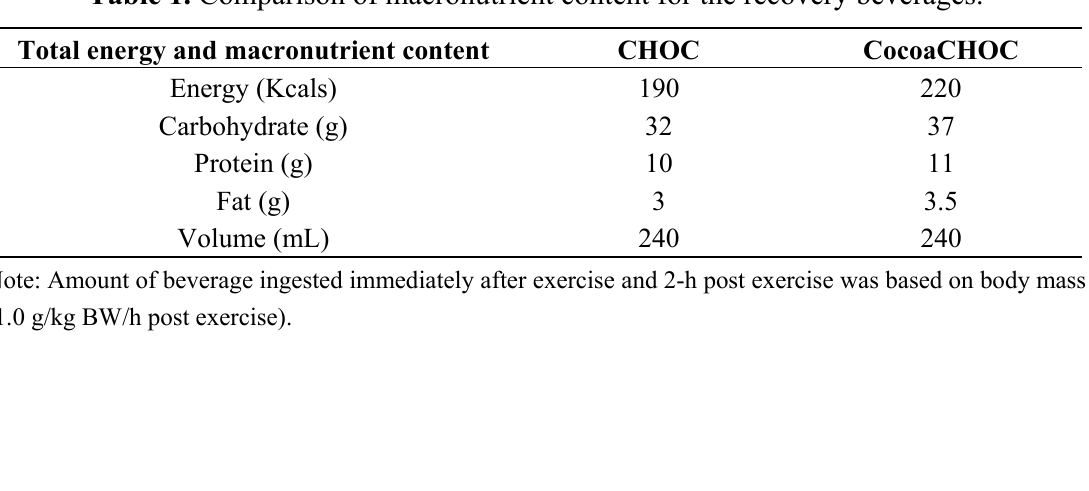
Table 1. Comparison of macronutrient content for the recovery